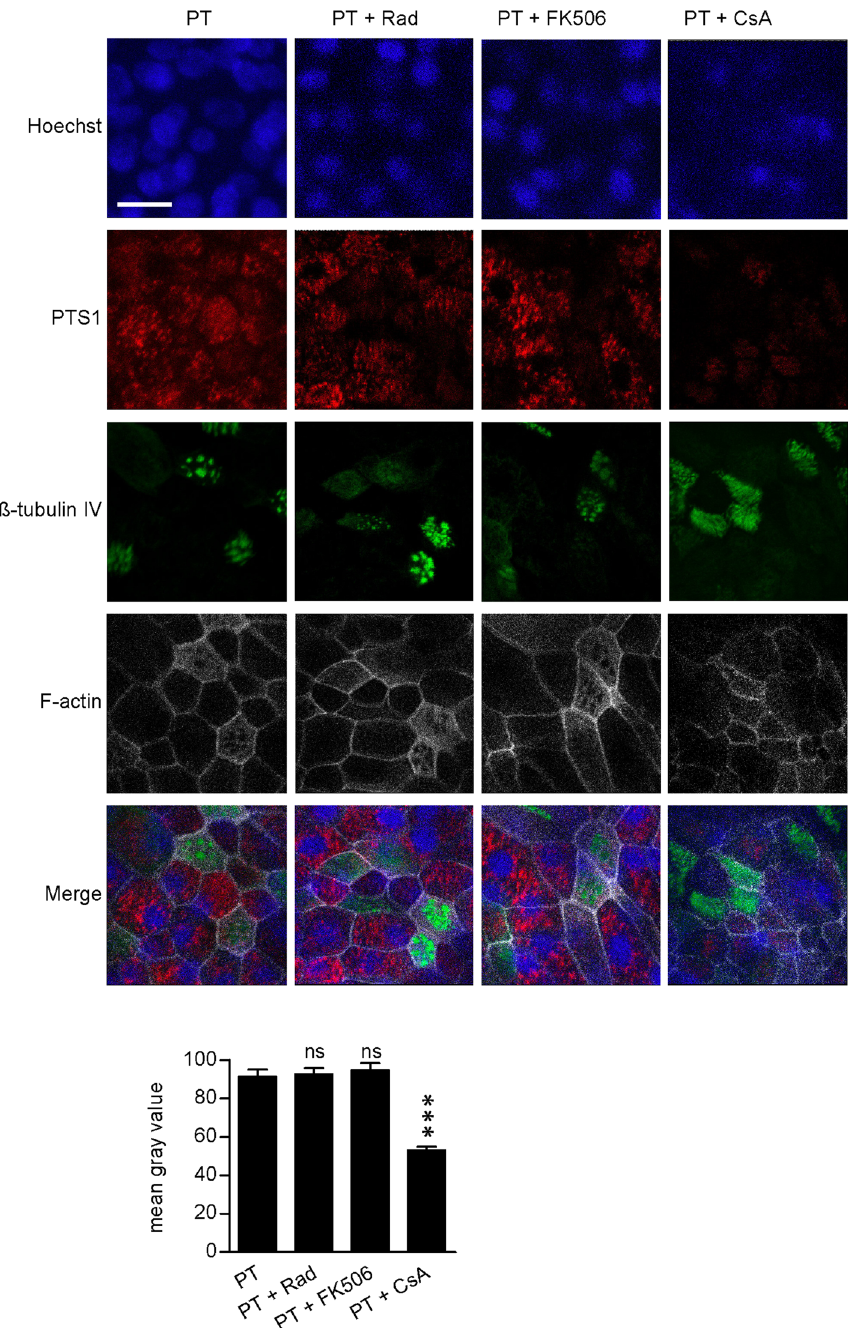
Figure 6. Effect of Rad, FK506 and CsA on uptake of PTS1 into hBAECs. hBAECs were pre-treated with respective inhibitors (20 µM) and then incubated with PT (20 µg/ml) from the apical side for 72 h. Cells were fixed with 4% PFA. For permeabilization and quenching of autofluorescence, cells were treated with 0.2% saponin. F-actin was stained with phalloidin-FITC. PTS1 and β-IV-tubulin were stained with specific primary and respective fluorescence-labeled secondary antibodies. Pictures were taken with a Cell Observer inverse microscope (Zeiss, Germany). Mean Gray Value Intensity was measured and plotted for PTS1 (after background subtraction) in PT and PT + inhibitor treated cultures. Values are given as mean ± SEM (n = 60 cells/condition). Significance was tested by Kruskal–Wallis test and refers to samples treated with only PT (***p < 0.001, ns not significant). Scale bar = 20